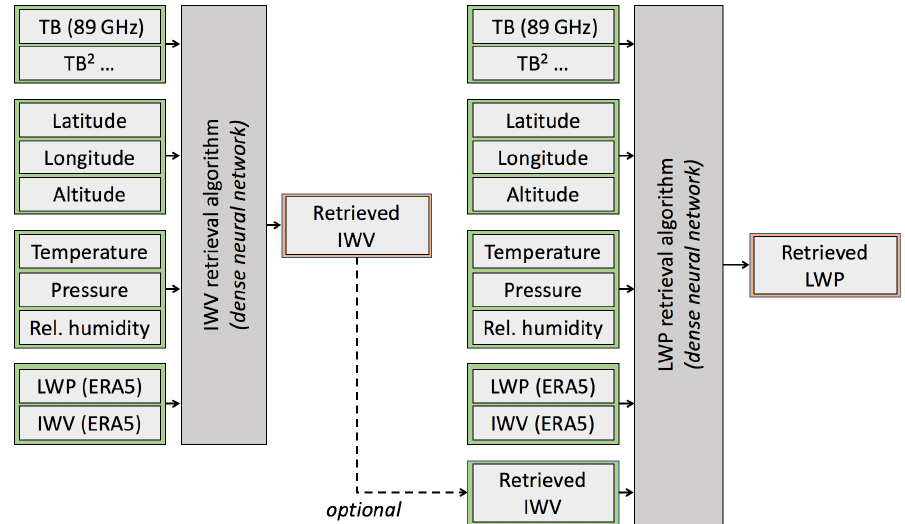
Figure 4. Structure of the retrieval algorithms. Some versions of the LWP retrieval include, among the input features, the output of the IWV retrieval. Note that the IWV and LWP algorithms are trained on different datasets. Table 1. Main parameters of the neural networks and training process. Target Neurons Layers Cost function Optimizer Activation Epochs Batch size IWV 120 7 Mean square error RMSprop ReLU 70 512 LWP 150 6 Mean square error RMSprop ReLU 90